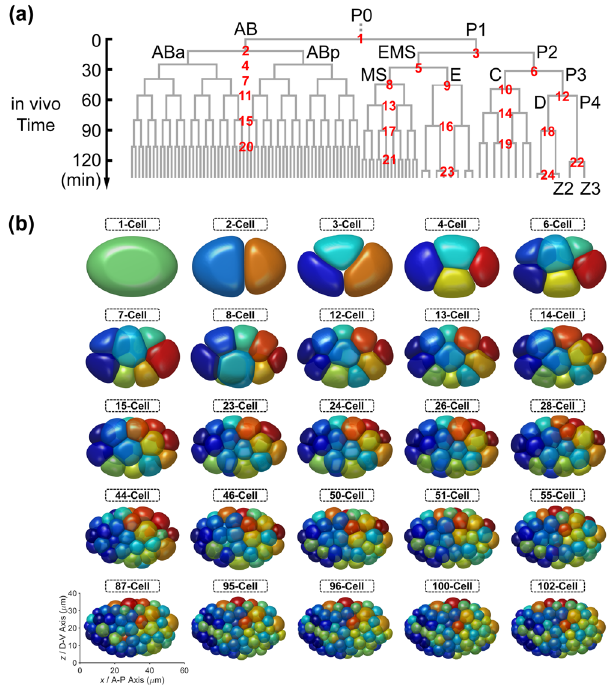
Fig. 5 The 1- to 102-cell C. elegans embryogenesis. a The cell lineage tree reconstituted from in vivo experiment. The cell divisions from the same founder cell (i.e., AB, MS, E, C, D, or P4) and in the same generation are regarded as synchronous; the cell cycle length of each division group is approximated with the shortest one among the cells obtained from experimental measurement 65 . The in vivo time axis is placed on the left and the cell division order is labeled near each cell division group. b The embryonic morphol- ogies generated by phase- fi eld simulation, using the cell division order and axis and volume segregation ratio measured experimen- tally as input. At each stage de fi ned by the cell division order in ( a ), the in silico time (i.e., simulation time) from 1- to 8-cell stages is introduced in Supplementary Note 1, while the one after the 8-cell stage is set to reach the equilibrium ( v < 1 ´ 10 (cid:2) 4 experimentally-measured shortest cell cycle length within the group as the common value 65 ; fi nally, we obtain the cell division order formed by 24 independent division groups as shown in Fig. 5a. Besides, the inputted cell division axis and volume segregation ratio are acquired from 48 (Supplementary Table 1).